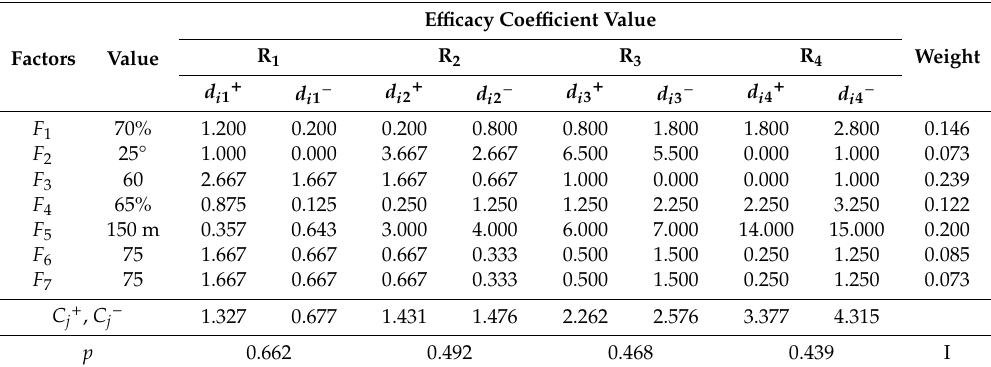
Table 7. Static risk evaluation for water and mud inrush.